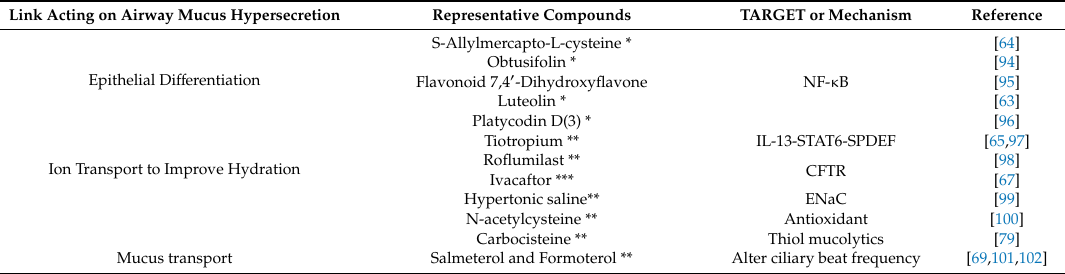
Table 2. Representative drugs and targets for the treatment of mucus